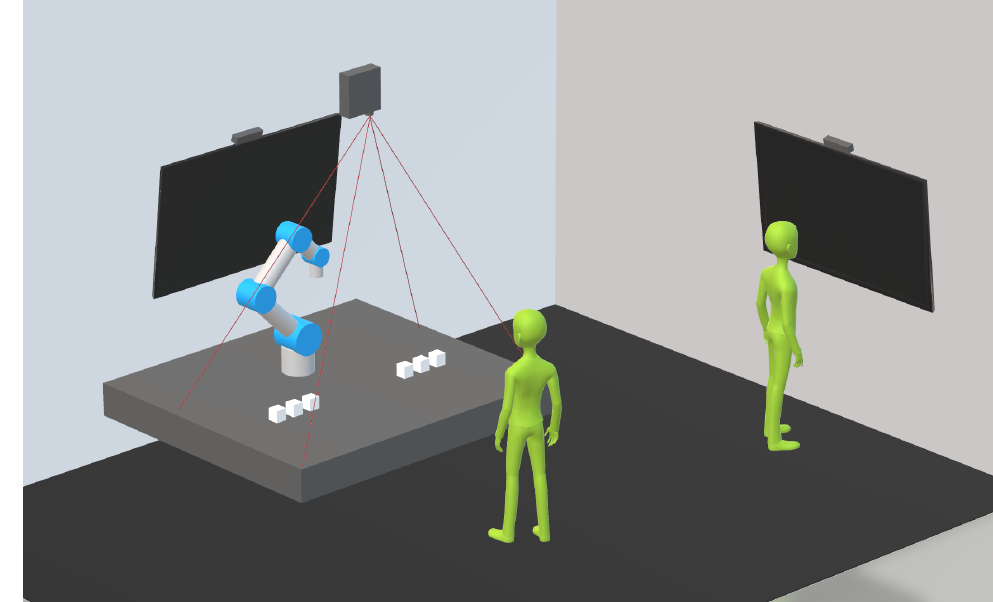
Figure 4. A schematic overview of the